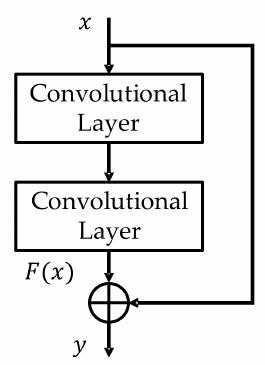
Figure 4. Structure of a residual